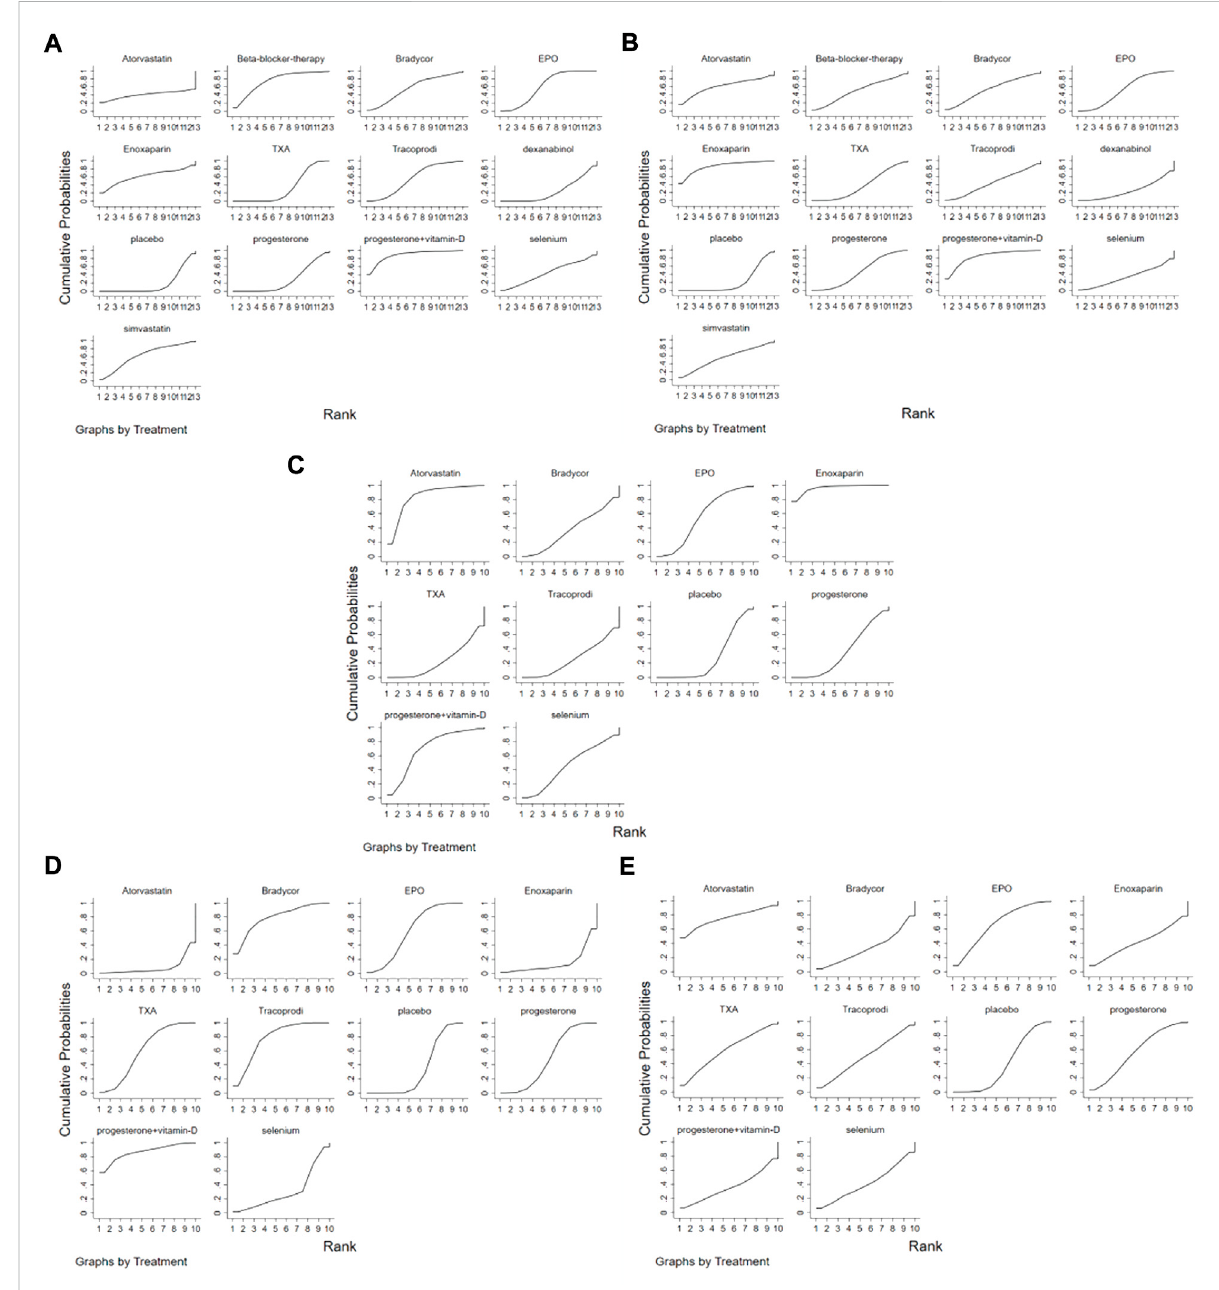
FIGURE 5 The Rank Chart; (A) The rank chart based on the mortality of TBI; (B) . The rank chart based on the patient proportion of the favorable result of TBI; (C) . The rank chart based on the patient proportion of the good recovery of TBI; (D) . The rank chart based on the patient proportion of the moderate disability of TBI; (E) . The rank chart based on the patient proportion of the severe disability of